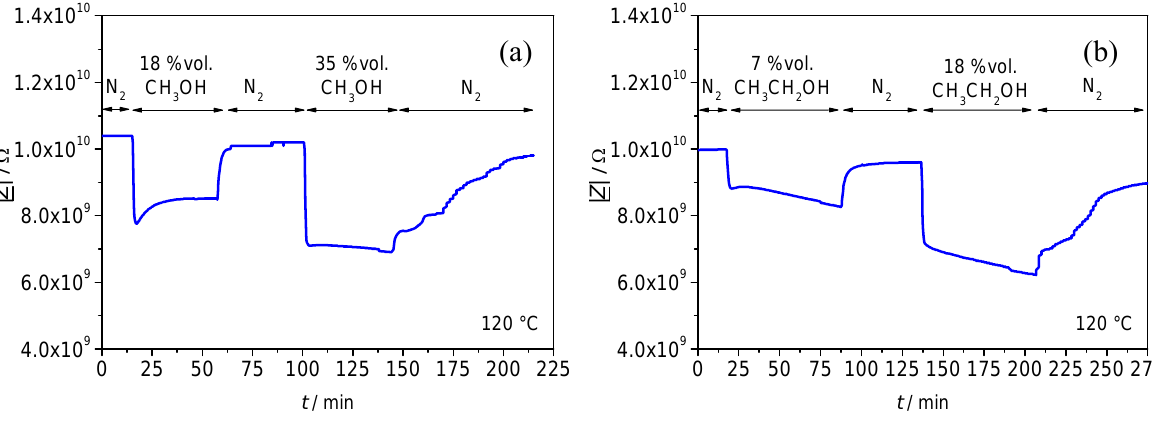
Figure 8. (a) Impedimetric sensor signal (| Z |) of a planar Fe-BTC sensor at 1 Hz for 0 - 35 vol% methanol in the test gas. (b) Impedimetric sensor signal (| Z |) of the same sensor